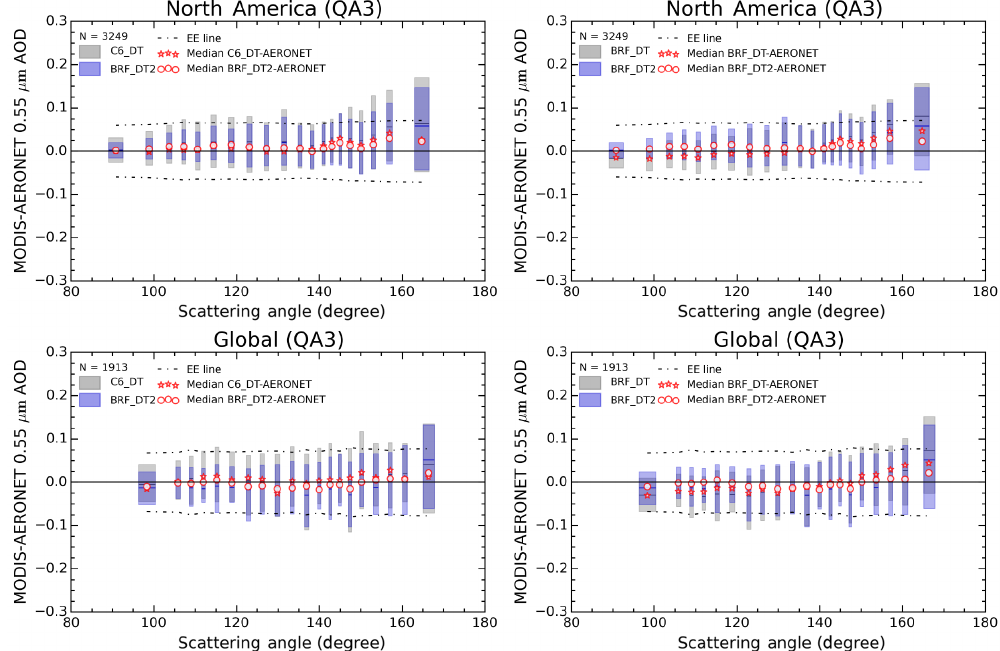
Figure 13. AOD at 0.55µm error as a function of scattering angle with QA = 3 (labeled as QA3). AOD error is defined as MODIS retrieved AOD − AERONET AOD, broken into equal number bins of scattering angles. The data are plotted for North America and the global land. The dash line and solid black line are EE and zero error. For each box, width is 1 σ of the scattering angles bin, whereas height and middle line are the 1 σ and mean of the AOD error, respectively. Shown in the first and second column is the performance between C6_DT and BRF_DT2 and between BRF_DT and BRF_DT2, respectively. Gray indicates C6_DT and BRF_DT and blue is BRF_DT2, whereas red stars are the median of AOD error for C6_DT and BRF_DT and red circles ones are for